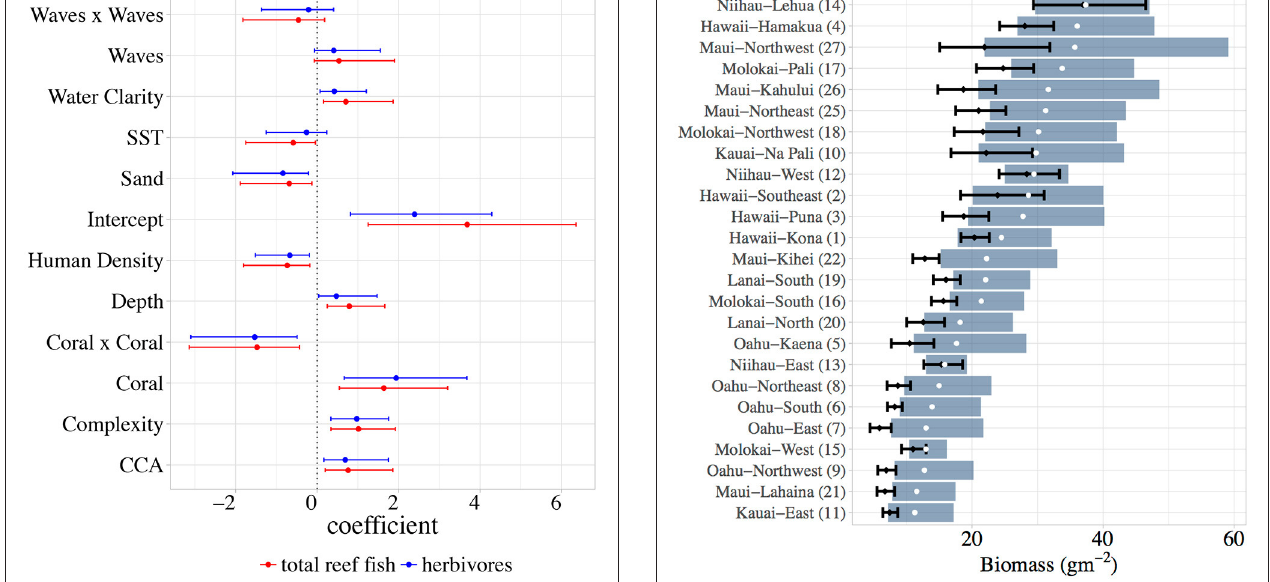
FIGURE 7 | Sector-level model predictions of present-day (black whiskers) vs. baseline (blue rectangles) biomass for total reef fish in the main Hawaiian Islands. Means and 66% Bayesian Credible Intervals are shown. Baseline biomass is calculated by setting human density to its present-day minimum across all fish-survey